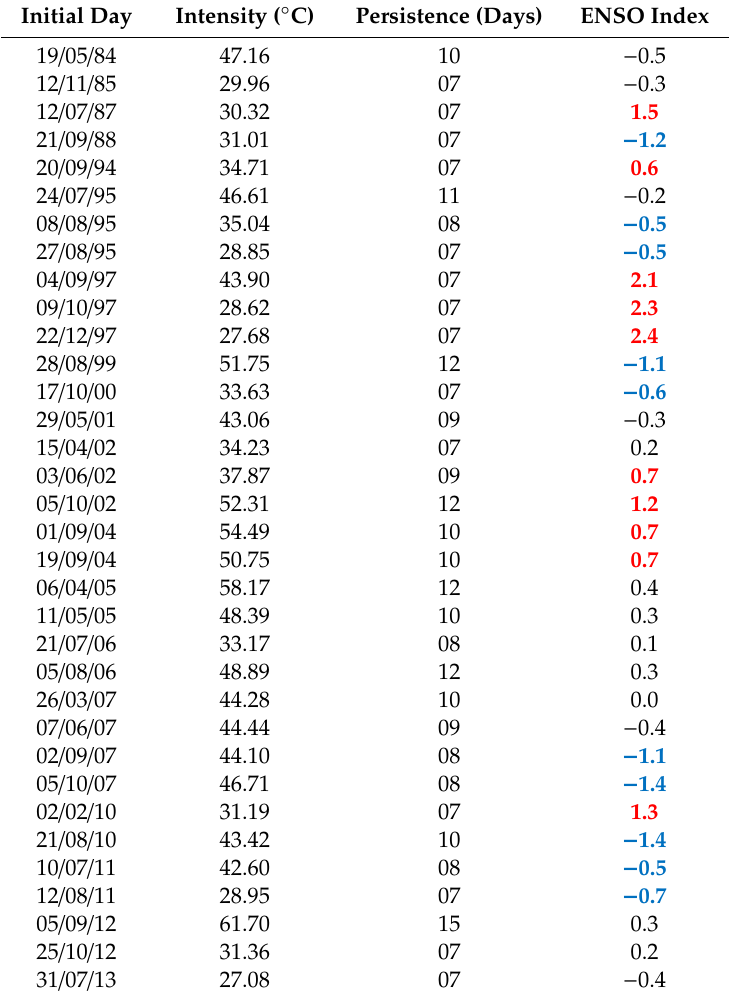
Table A2. Heat waves’ initial day in region 2, intensity (cumulative Tmax anomalies) of each heat wave, its persistence and index values of